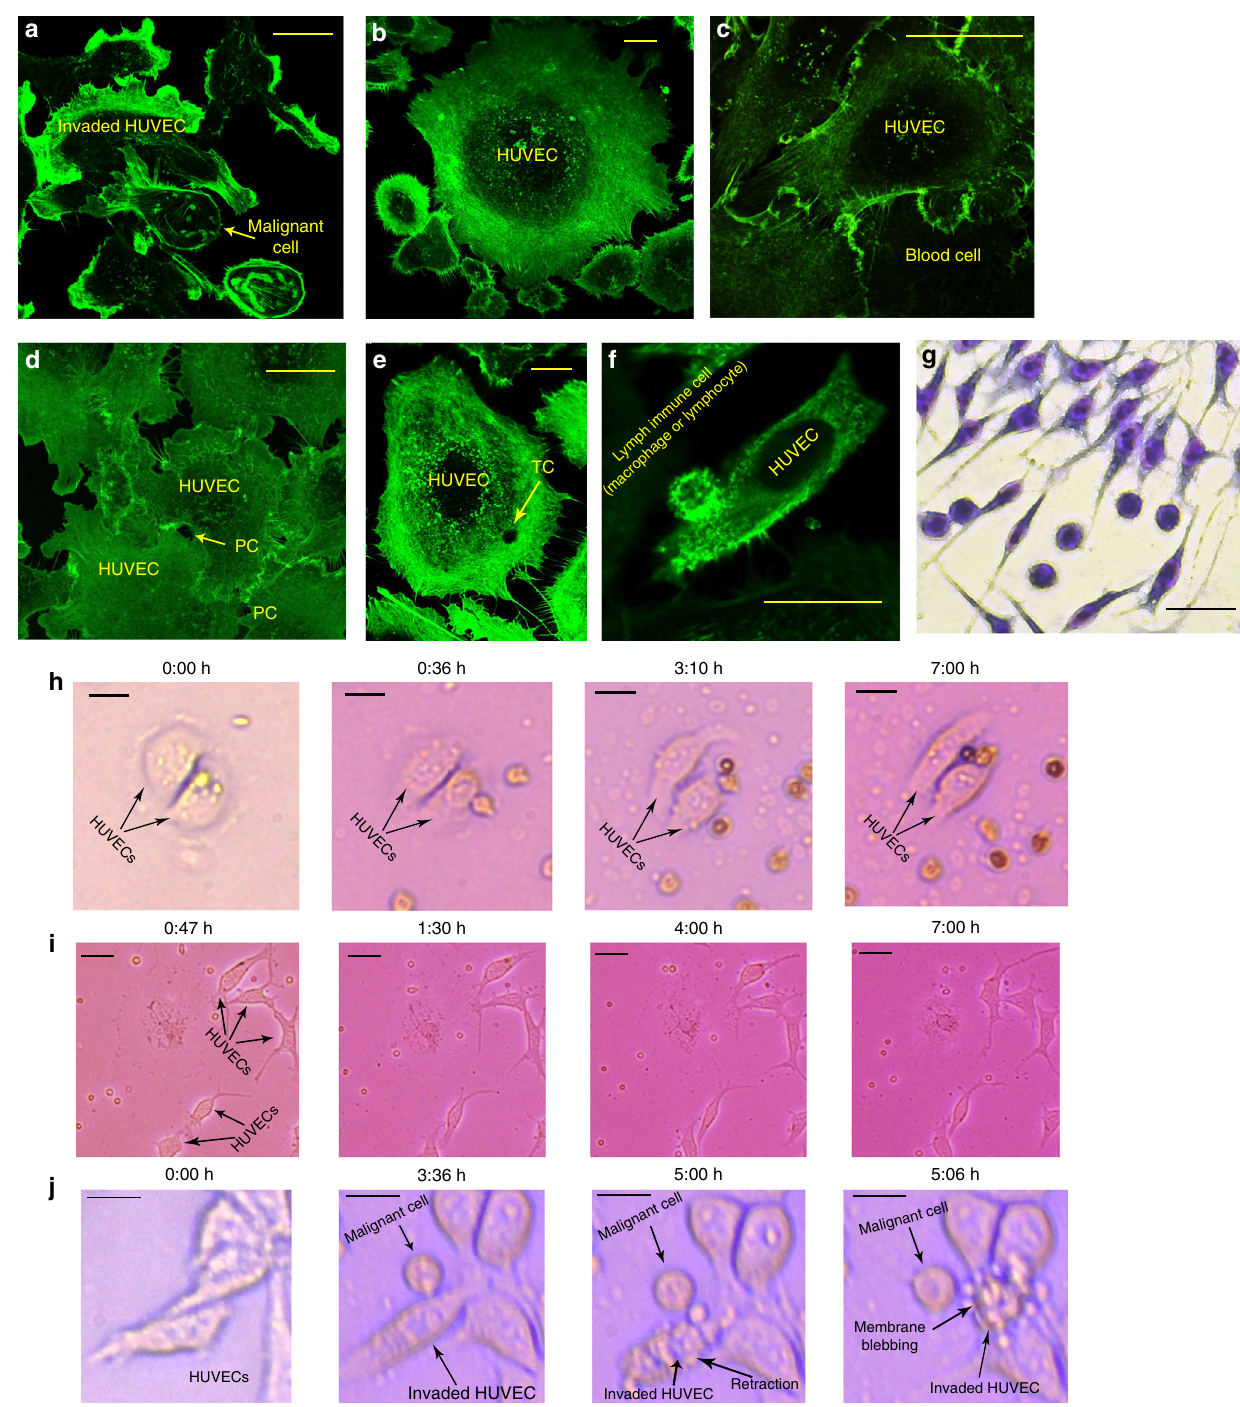
Fig. 6 a Confocal images from the interaction of two individual malignant cell samples by HUVEC traps. Retraction of the membrane and signs of membrane blebbing could be observed. b Similar images were taken from the interaction of non-malignant lymph nodes and HUVECs, and no retraction was observed in the structure of interacted HUVECs. c Migration and diffusion of a non-malignant blood cell, derived from a healthy donator, into the HUVEC trap. d The trace of the hole produced by transcellular migration of leukocytes could be observed. e Similar confocal images from non-retracted endothelial layer after TC of blood immune cells . f Attachment of an immunocell existed in a non-malignant lymph node to the HUVEC. Note: all of the images were taken after at least 6 h of interaction between the cells and HUVECs. g Geimsa staining image taken after 7 h of interaction between WBCs (of a healthy donator) and HUVECs. Optical time-lapse images of h non-metastatic lymph; i healthy blood; and j metastatic lymph samples in interaction with single HUVECs. HUVEC retraction and membrane blebbing was only induced by the metastatic cell ( i ). Related Supplementary Movies: g Supplementary Movie 6 h Supplementary Movie 7 i Supplementary Movie 8. The scale bars are 25 µ m in